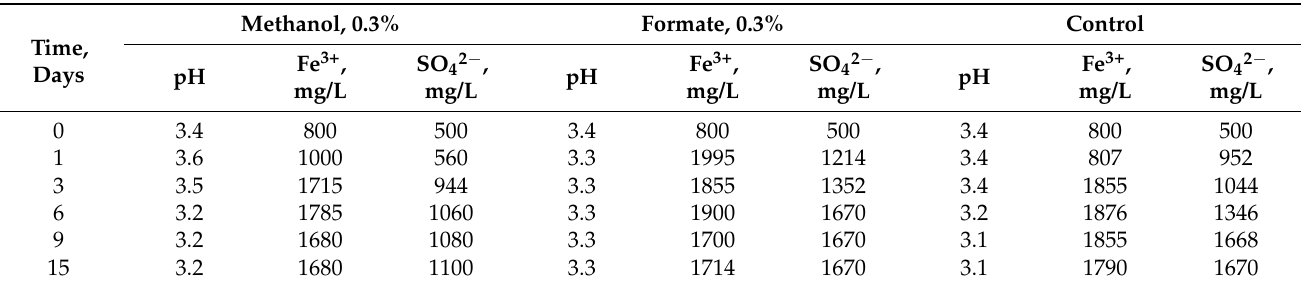
Table 4. The effect of formate and methanol additions on the leaching of iron and sulfates from a sample of arsenopyrite concentrate by A. ferrooxidans TFBk bacteria. Control is the leaching in the medium without addition of formate and methanol.